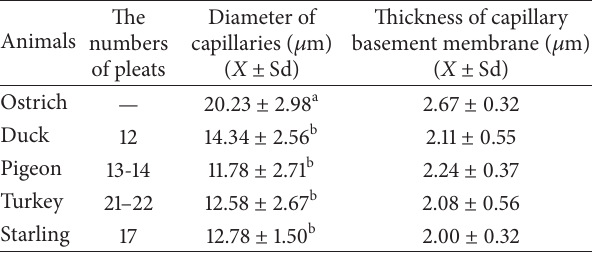
Table 1: The morphometric parameters of pecten oculi in different avian